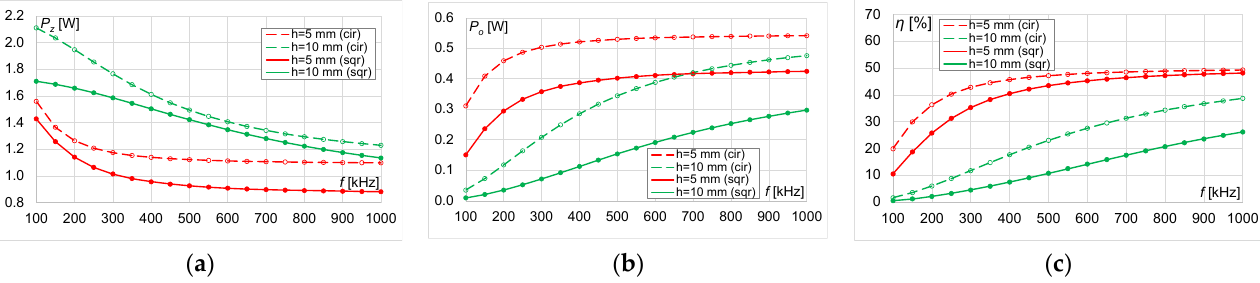
Figure 19. Results for circular and square coils with r = 10 mm and number of turns n = 15 at different distances ( h = 5 mm and h = 10 mm): ( a ) transmitter power, ( b ) receiver power and ( c ) power transfer efficiency.